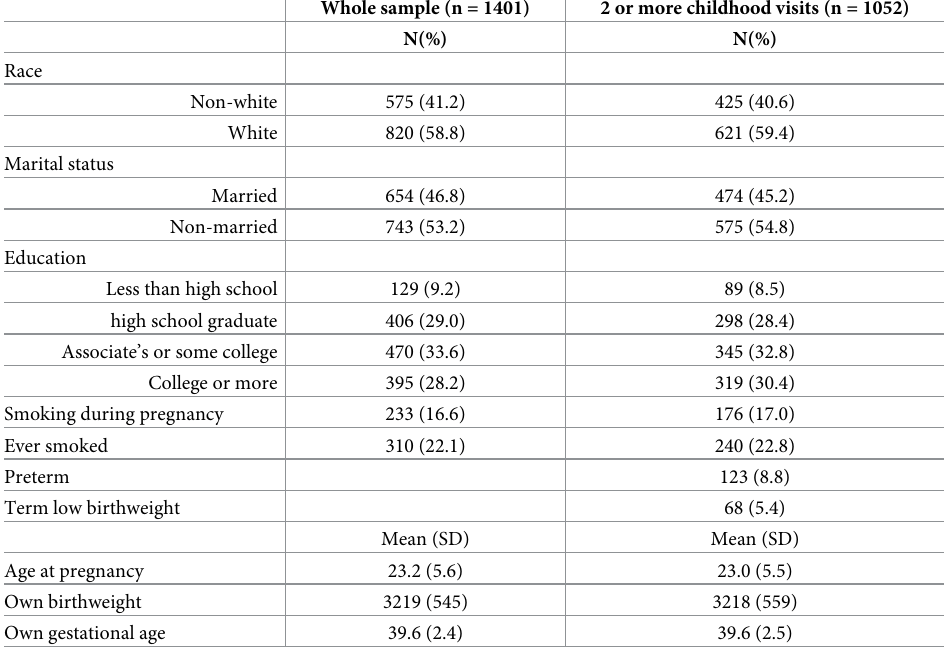
Table 1. Characteristics of the study population (n = 1401) all singleton first births occurring after age 16 among women with at least 1 BHS visits before age 16. Whole sample (n = 1401) 2 or more childhood visits (n = 1052)